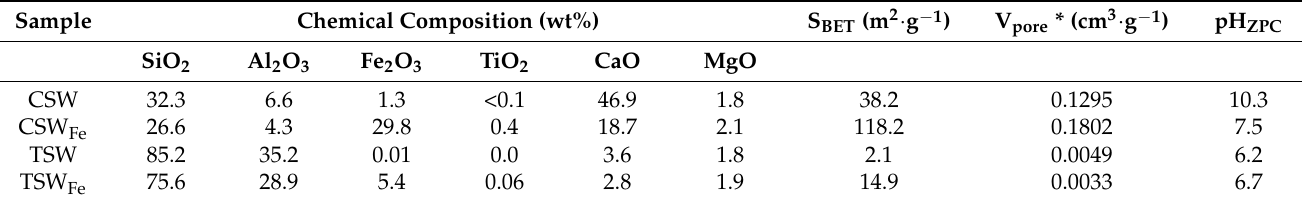
Table 1. Chemical and surface properties of CSW/CSW Fe and TSW/TSW Fe